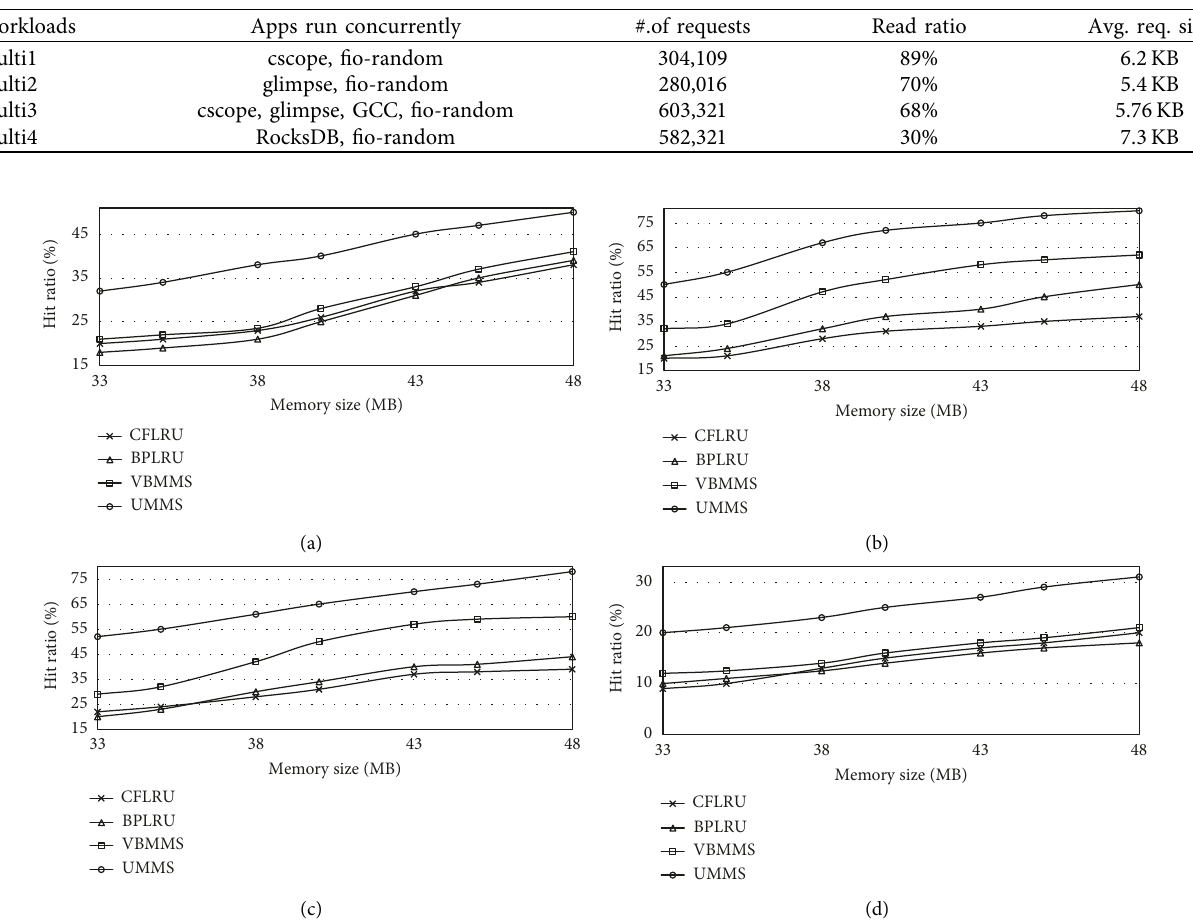
Table 1: Specification of workloads.